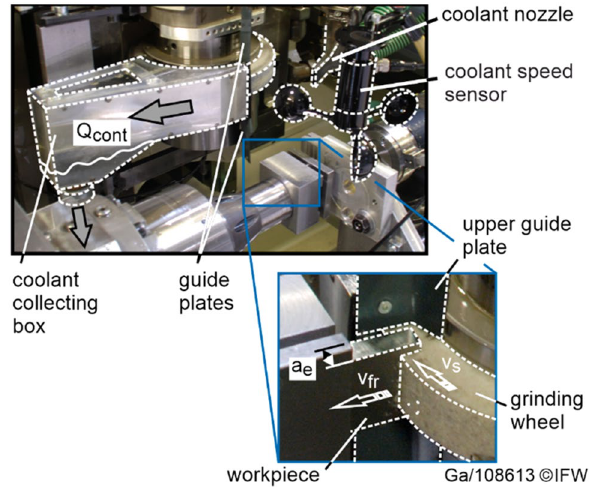
Fig. 5 Experimental setup for collection of coolant within the KAPP KX1 machine